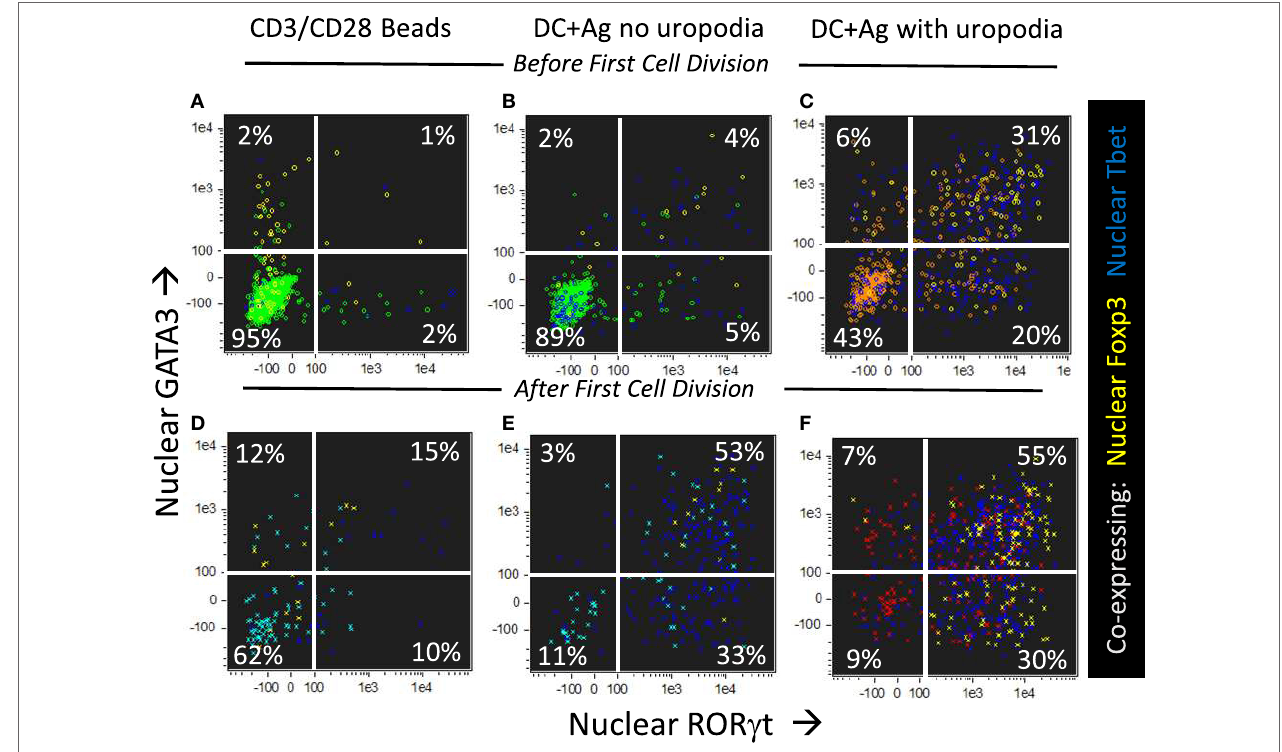
FigUre 11 | CD4 + T cells with uropodia are effector cells co-expressing random combinations of T cell subset transcription factors. (a–F) Cell trace violet (CTV) labeled female MARKI CD4 + T cells were stimulated as indicated with either CD3/CD28 beads (a,D) or bone marrow-derived dendritic cells (bmDC) + 10 nM Dby peptide (b,c,e,F) , for 2 days with IL-2, TGF β , and ATRA. Cultures were labeled “ in situ ” with CD4-APC-Cy7, live/dead aqua, and Mitotracker DR, fixed and permeabilized, and intracellularly for pS6-Alexa 488, GATA3-PE, ROR γ t-PE-CF594, Foxp3-PE-Cy7, Tbet-BV605, and 7AAD. 50,000 images were acquired per sample, and gated for live singlet cells in G 0 /G 1 with [ (b,e) area > 10 μ m 2 in green] or without [ (c,F) area < 10 μ m 2 in red] uropodia, and, using CTV dilution, for cells that had not yet divided (a–c) or had divided once or more (D–F) . Dot plots show the intensity of nuclear staining for ROR γ t versus GATA3, with co-expression of nuclear Foxp3 (yellow) or Tbet (blue) also indicated. One of five similar experiments is shown (two with MARKI, three with